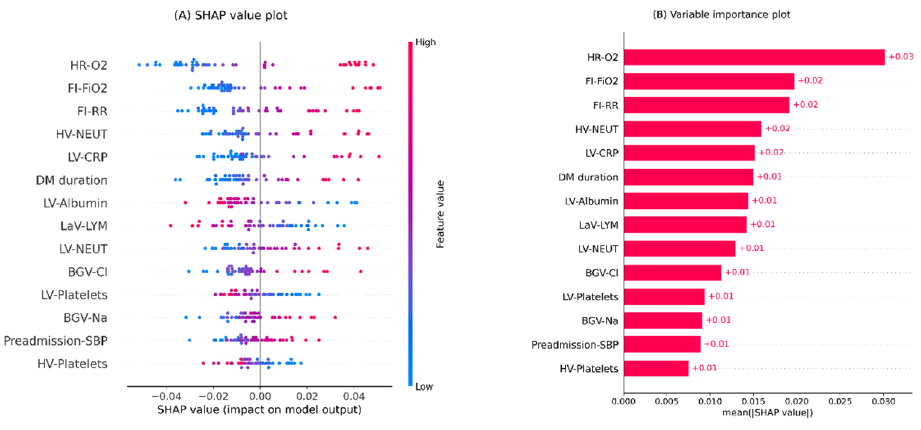
Figure 4. Global interpretation plots for the updated inpatient COVID-19 mortality prediction model. ( A ) Bee swarm SHAP values plot, ( B ) SHAP summary importance plot. The bee swarm plot shows all SHAP values in accord with predictors values. The summary plot presents predictors in descending order based on their overall importance on the model’s outcomes derived from mean absolute SHAP values. Note. BGV: blood gas value; Cl: chloride; CRP: c-reactive protein; DM: diabetes mellitus; FI: first inpatient; FiO2: fraction of inspired oxygen; HR: highest requirement; HV: highest value; LaV: last value; LV: lowest value; LYM: lymphocytes; Na: sodium; NEUT: neutrophils; O2: oxygen;